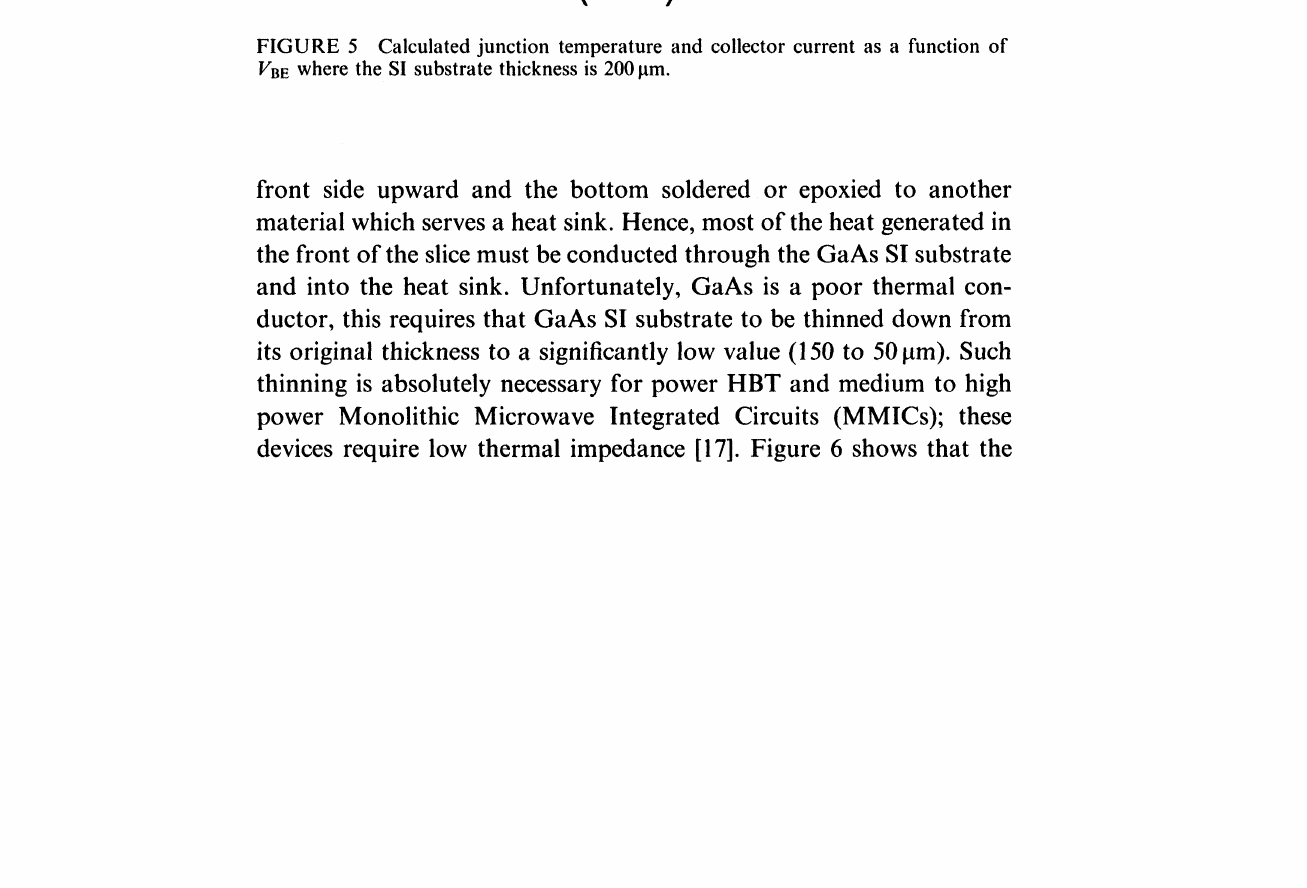
FIGURE 5 Calculated junction temperature and collector current as a function of VBE where the SI substrate thickness is